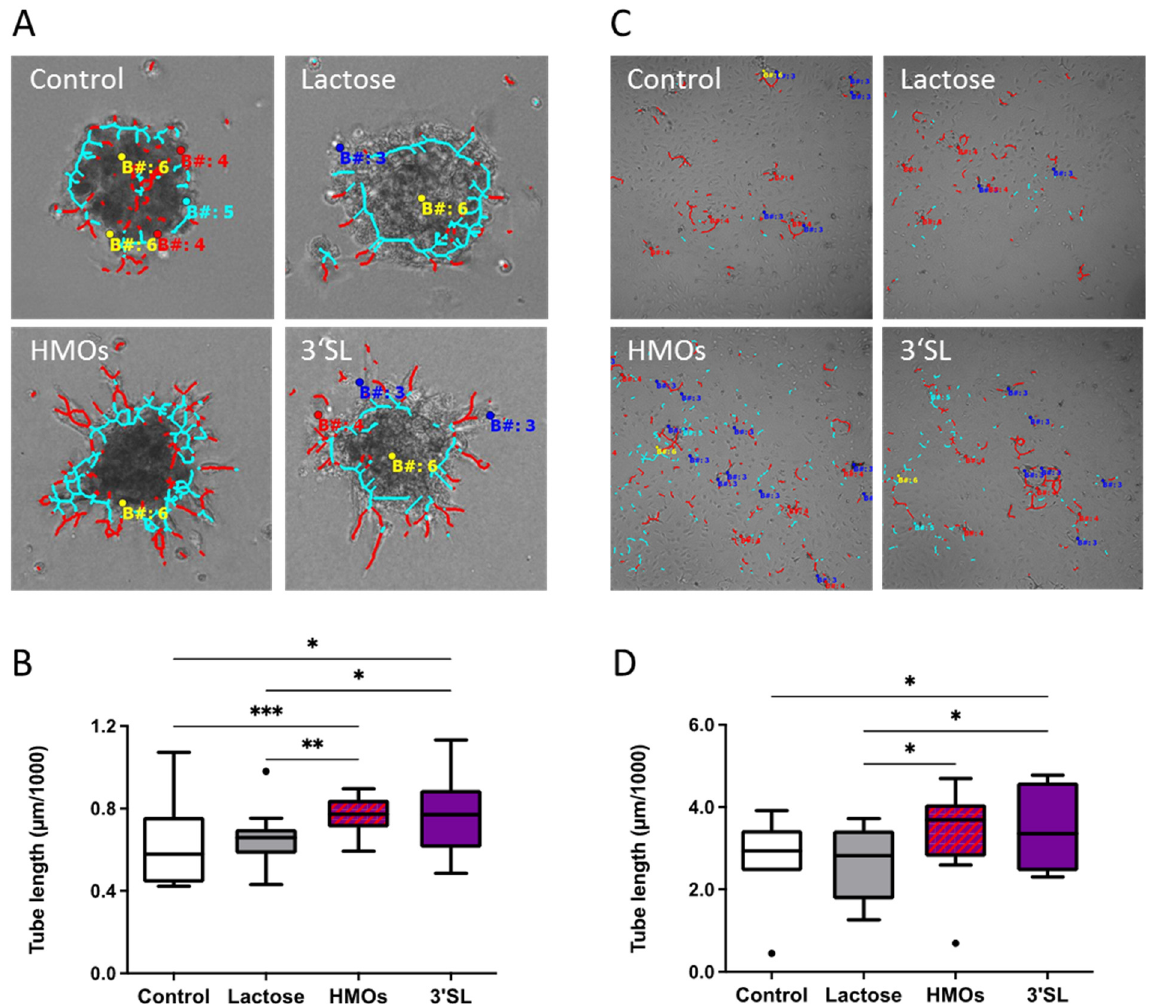
Figure 5. HMOs stimulated in vitro angiogenesis of fpECs. A set of n = 10 individual fpEC isolations from healthy placentas were used for spheroid assays ( A , B ) and fibrin assays ( C , D ). ( A , B ) Spheroid assay showed significantly increased sprouting in the presence of HMOs (100 µg/mL) or 3 ′ SL (30 µg/mL) as compared to untreated control. Lactose served as non-HMO control. ( A ) Representative image of spheroids analyzed with Cell-IQ analyzer software. Red lines are measuring the sprouts. ( B ) Box blots show median of tube length in the respective treatments. ( C ) Representative images of tubes analyzed with the Cell-IQ analyzer. The red dots and lines represent the tubes. ( D ) Fibrin assay showed a significant increase in total tube length upon treatment with HMOs (100 µg/mL) and 3 ′ SL (30 µg/mL), compared to untreated cells and cells treated with lactose. Repeated measures ANOVA with uncorrected Fisher’s LSD; * p < 0.05; ** p < 0.01; *** p < 0.001; n = 10.